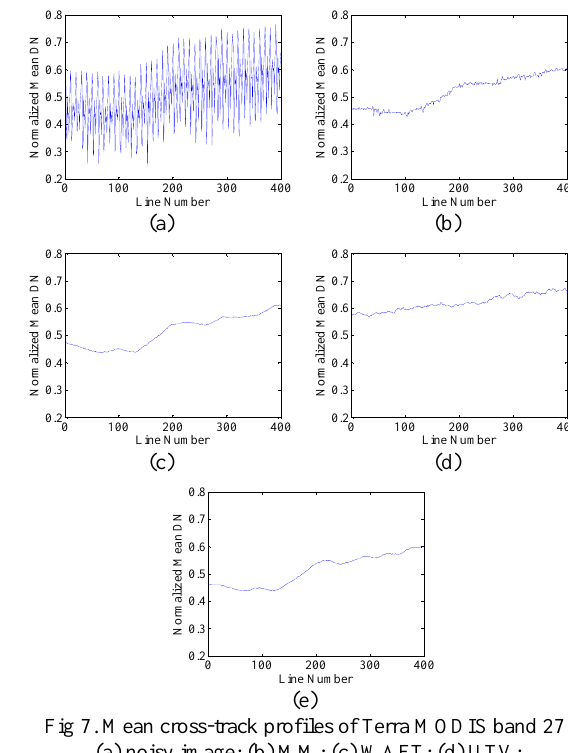
Fig 7. Mean cross-track profiles of Terra MODIS band 27: (a) noisy image; (b) MM; (c) WAFT; (d) UTV; and (e) the proposed method.